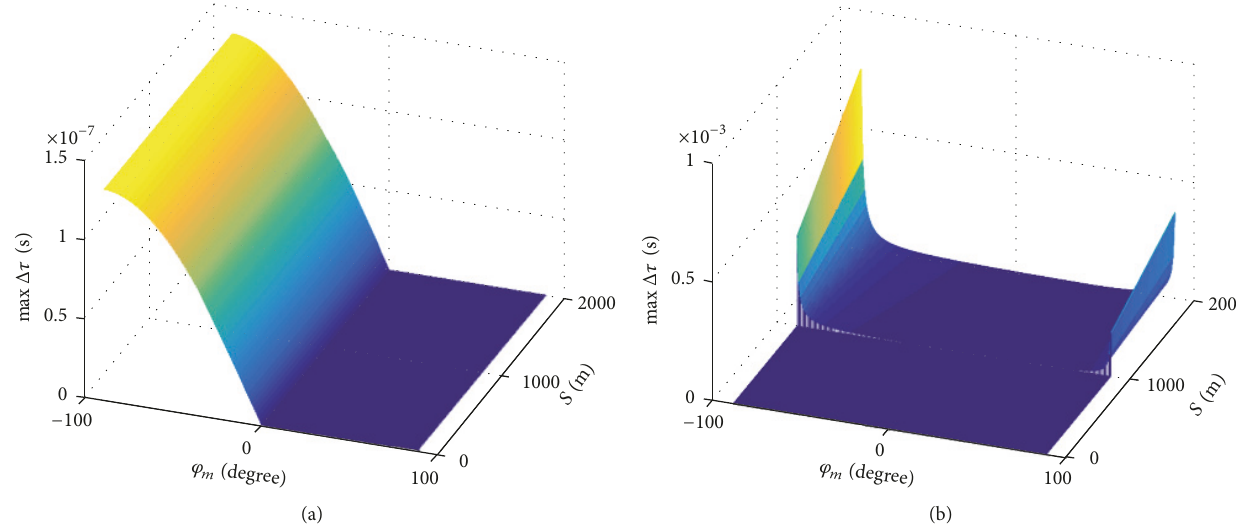
Figure 2: In this figure, the height 𝐻 of the antenna is set to 20 m and the radius 𝑆 0 of the semiopen land is 2000 m. (a) shows propagation time delays of multipath signals produced by horizontal surfaces. The delay is only relative to the elevation angle of the direct signal. (b) shows propagation time delays of multipath signals produced by inclined surfaces. The delay increases by the distance 𝑆 and the absolute value of elevation angle 𝜑 𝑚